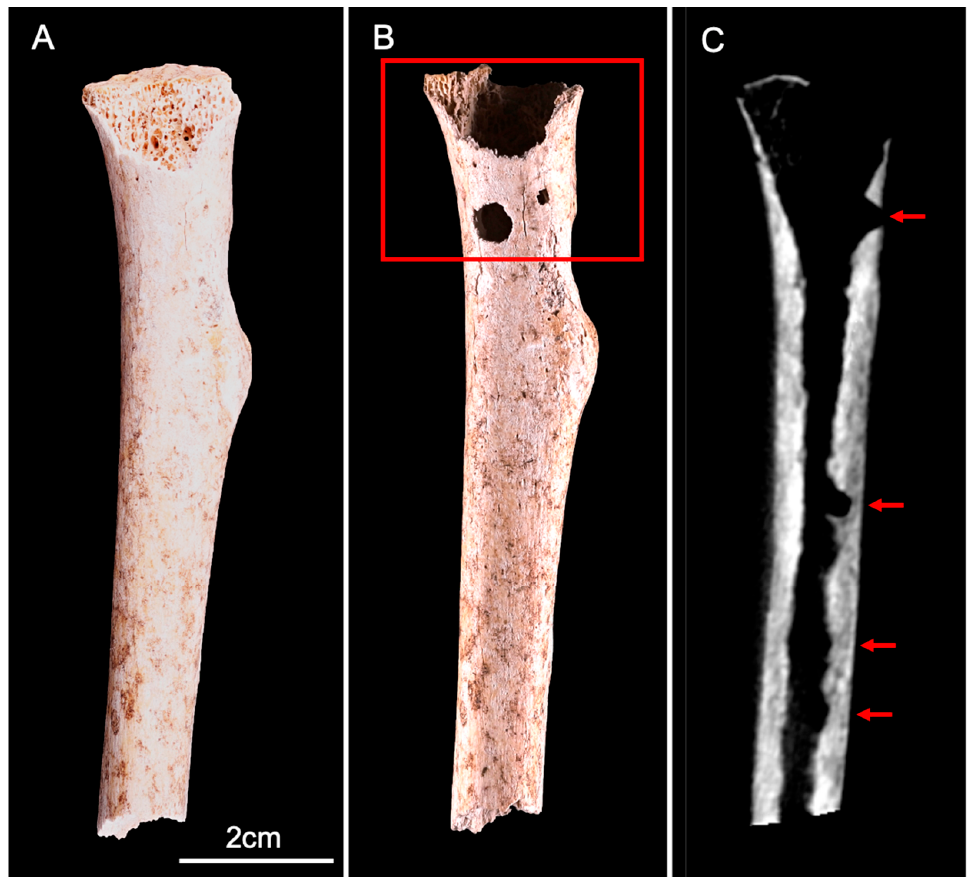
Figure 5. Anterior view of the human radius (proximal fragment) before ( A ) and after ( B ) the experiment. We observed an extensive destruction of the proximal epiphysis trabecular bone, associated with two cortical perforations (red square). ( C ) CBCT longitudinal section shows the trabecular destruction and thinning of the cortical inner surface (red arrows).